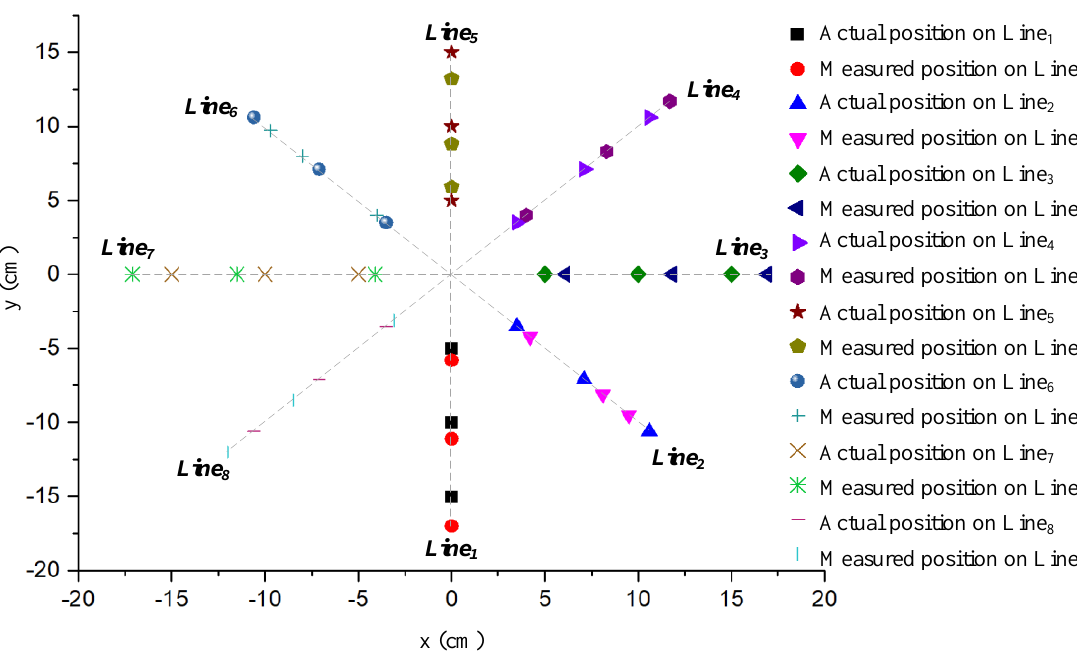
Figure 13. Comparison between the measured value and the actual value in each direction.